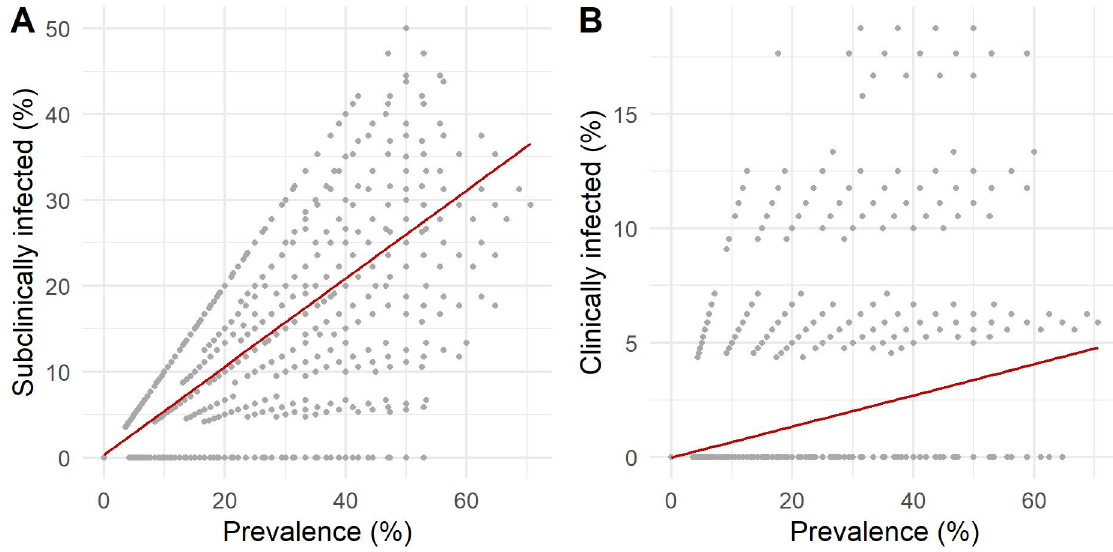
Figure 5. Correlations between the prevalence of Mycobacterium avium subsp. paratuberculosis within the herd and ( A ) the proportion of subclinically infected cows and ( B ) clinically infected cows per herd.